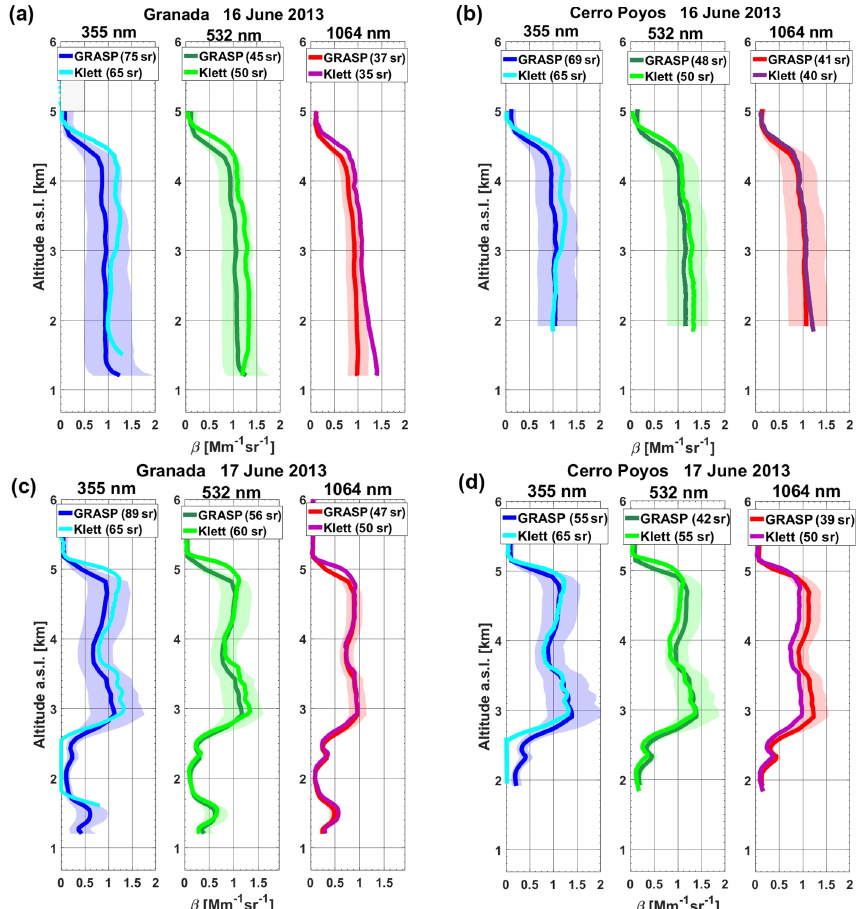
Figure 7. Aerosol backscatter coefficient profiles retrieved at 355, 532 and 1064nm by GRASP with its uncertainty (shaded area) and Klett–Fernald on 16 (a, b) and 17 (c, d) June 2013 at Granada (a, c) and Cerro Poyos (b, d)